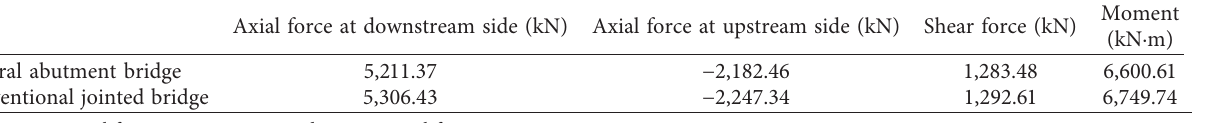
Table 10: Internal force of piers.